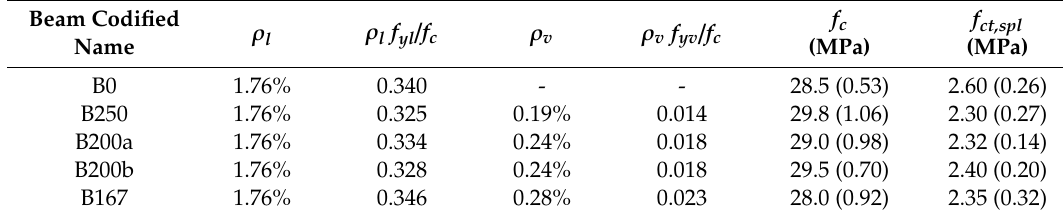
Table 1. Reinforcement ratios and concrete strength of the initially tested beams.